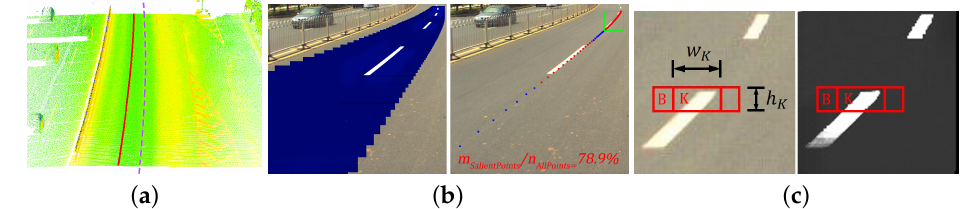
Figure 27. Textural saliency analysis for near-vehicle lane markings. ( a ) The dotted purple line is the trajectory, and the red line is the inferred lane line. ( b ) The inferred lane line is sampled and mapped to the image, as shown on the right. Through textural saliency analysis, the valid points are marked in red and the invalid ones are marked in blue. The saliency values of the buffers around the sampling points are shown on the left. ( c ) In the buffer denoted by the green box in ( b ) the detector window is shown on the left and the saliency map on the